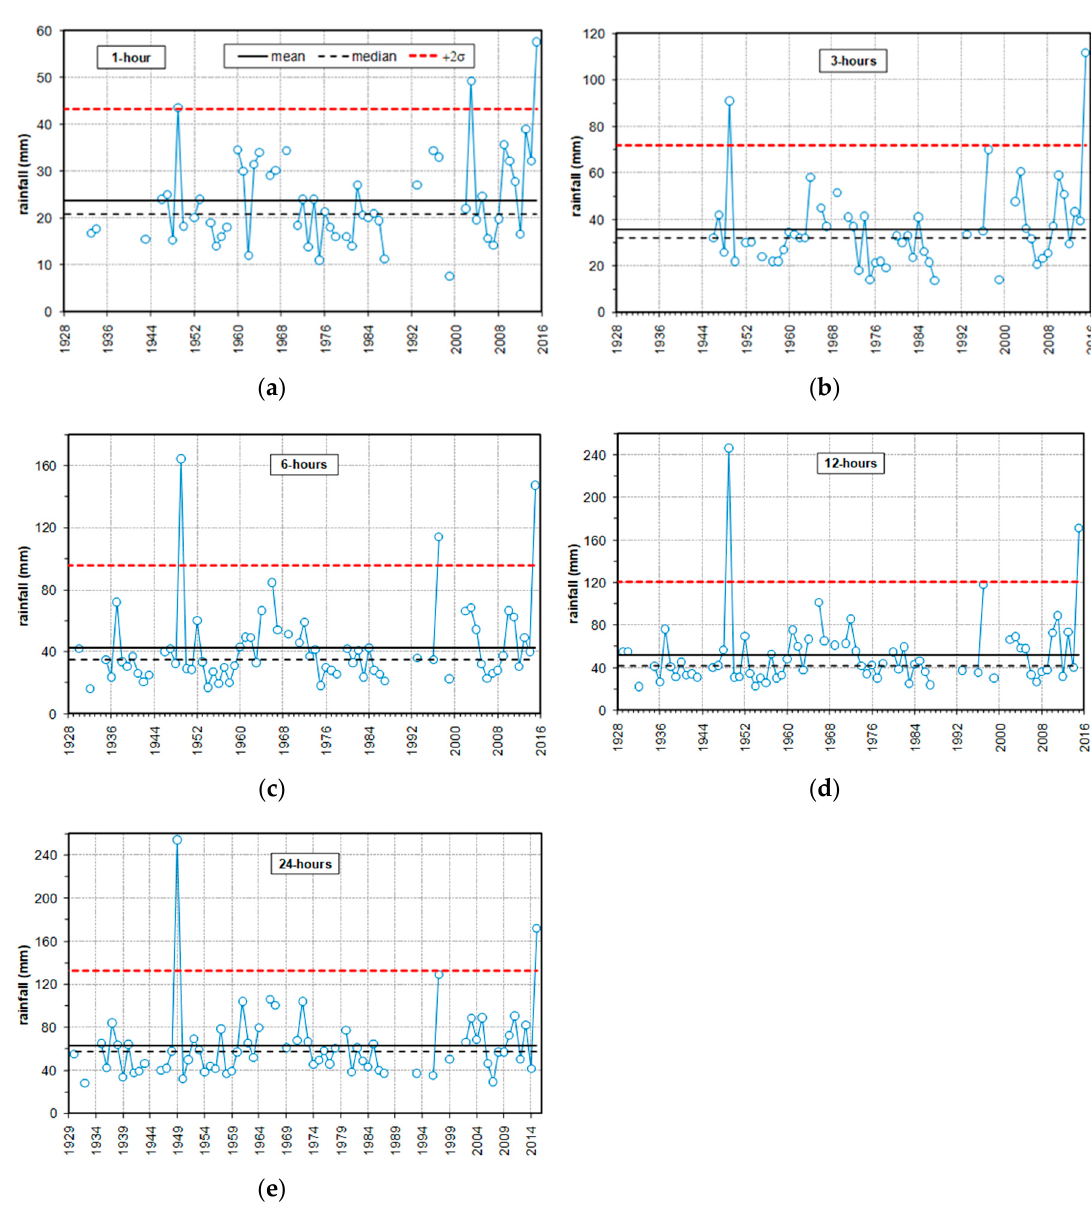
Figure 5. Time series of annual rainfall maxima in 1, 3, 6, 12, and 24 h from the S. Croce del Sannio rain gauge (724 m a.s.l., from 1929 to 1999) and the Colle Sannita rain gauge (740 m a.s.l., from 2002 to 2015). The mean, median, and mean +2 standard deviations (+2 σ ) are also shown. Some data are missing.